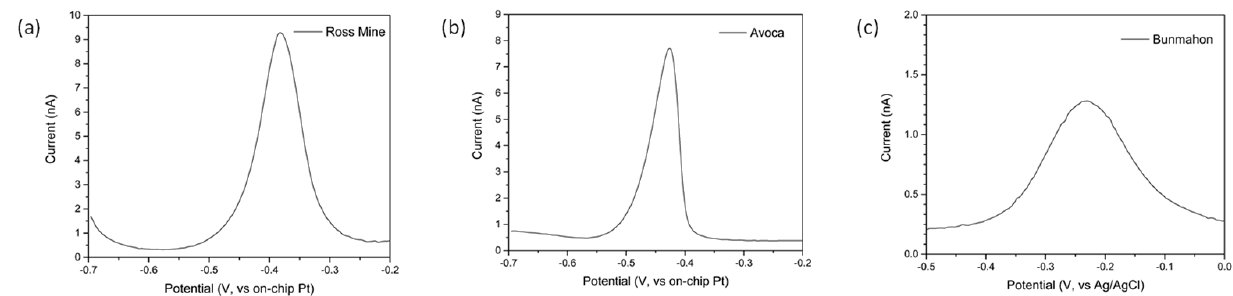
Figure 7. Square wave voltammograms of samples collected from ( a ) Ross mine; ( b ) Avoca and ( c ) Bunmahon (an Ag/AgCl reference electrode was used in this instance) sites. Solutions were adjusted to pH 2 on-site using mineral acid. Table 2. Comparison of results obtained with ICP-MS and electrochemical